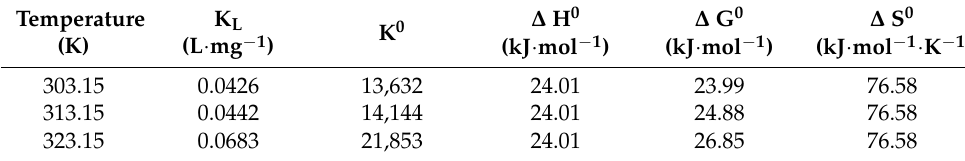
Table 4. Change of adsorption potential of MB on chestnut shell-based activated carbon. Adsorption Temperature, K